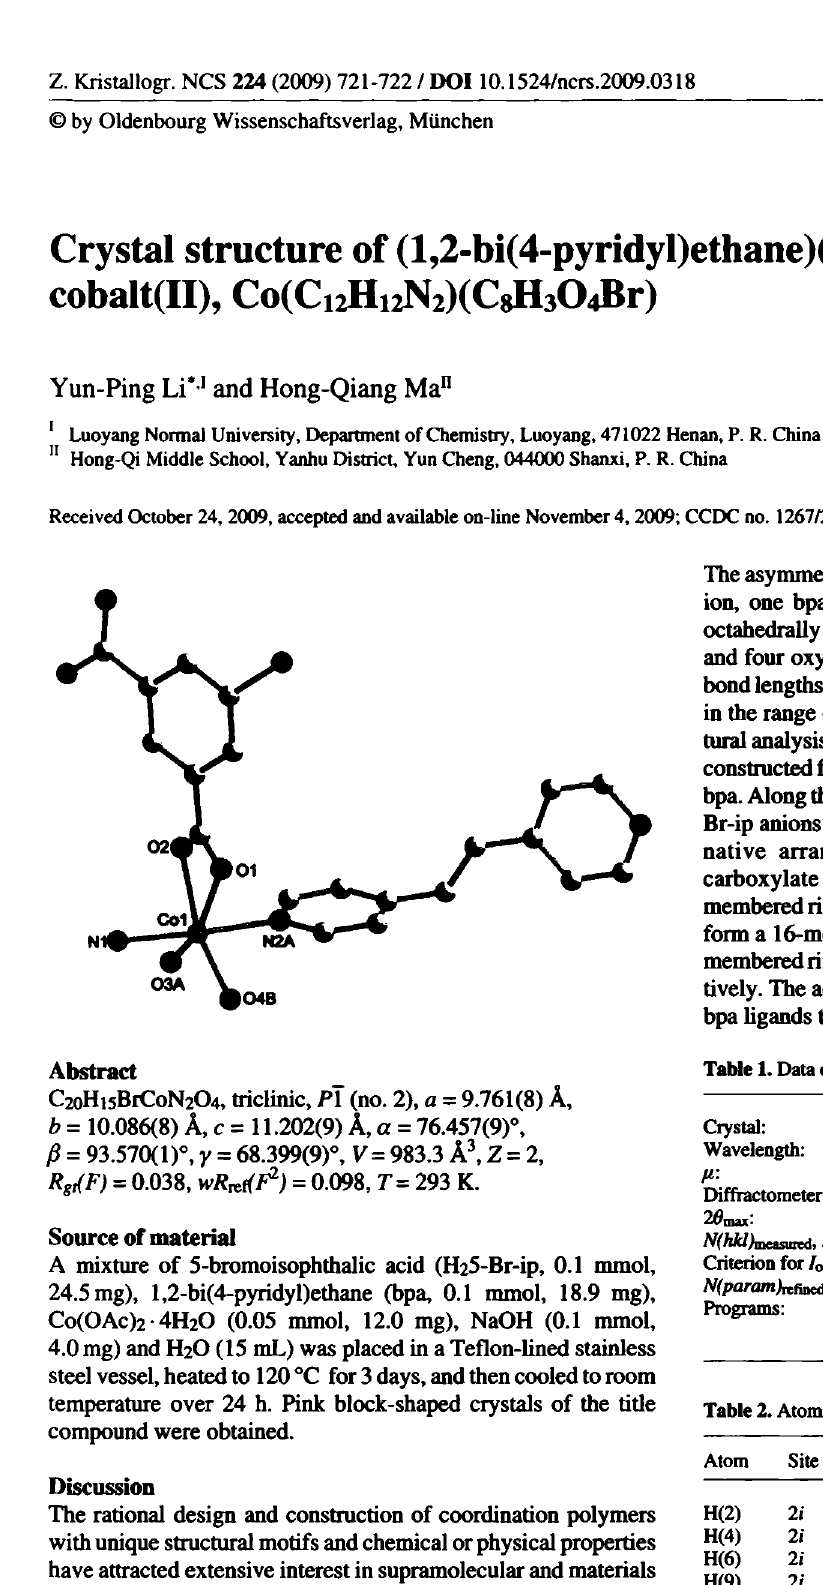
Table 2. Atomic coordinates and displacement parameters (in Â 2